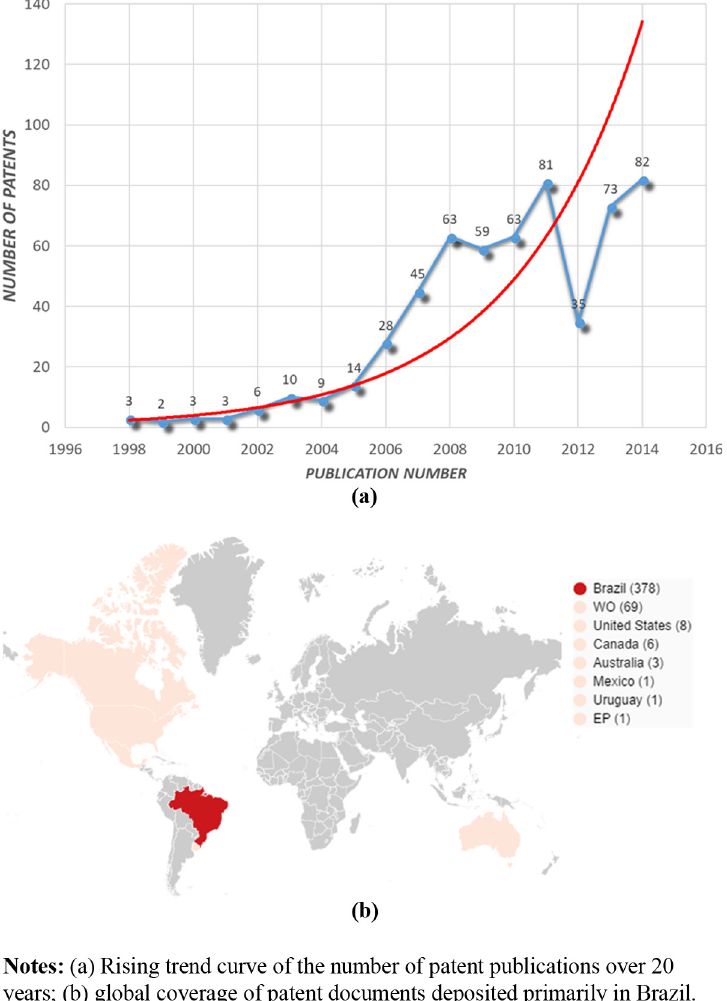
Figure 1. Evolution of